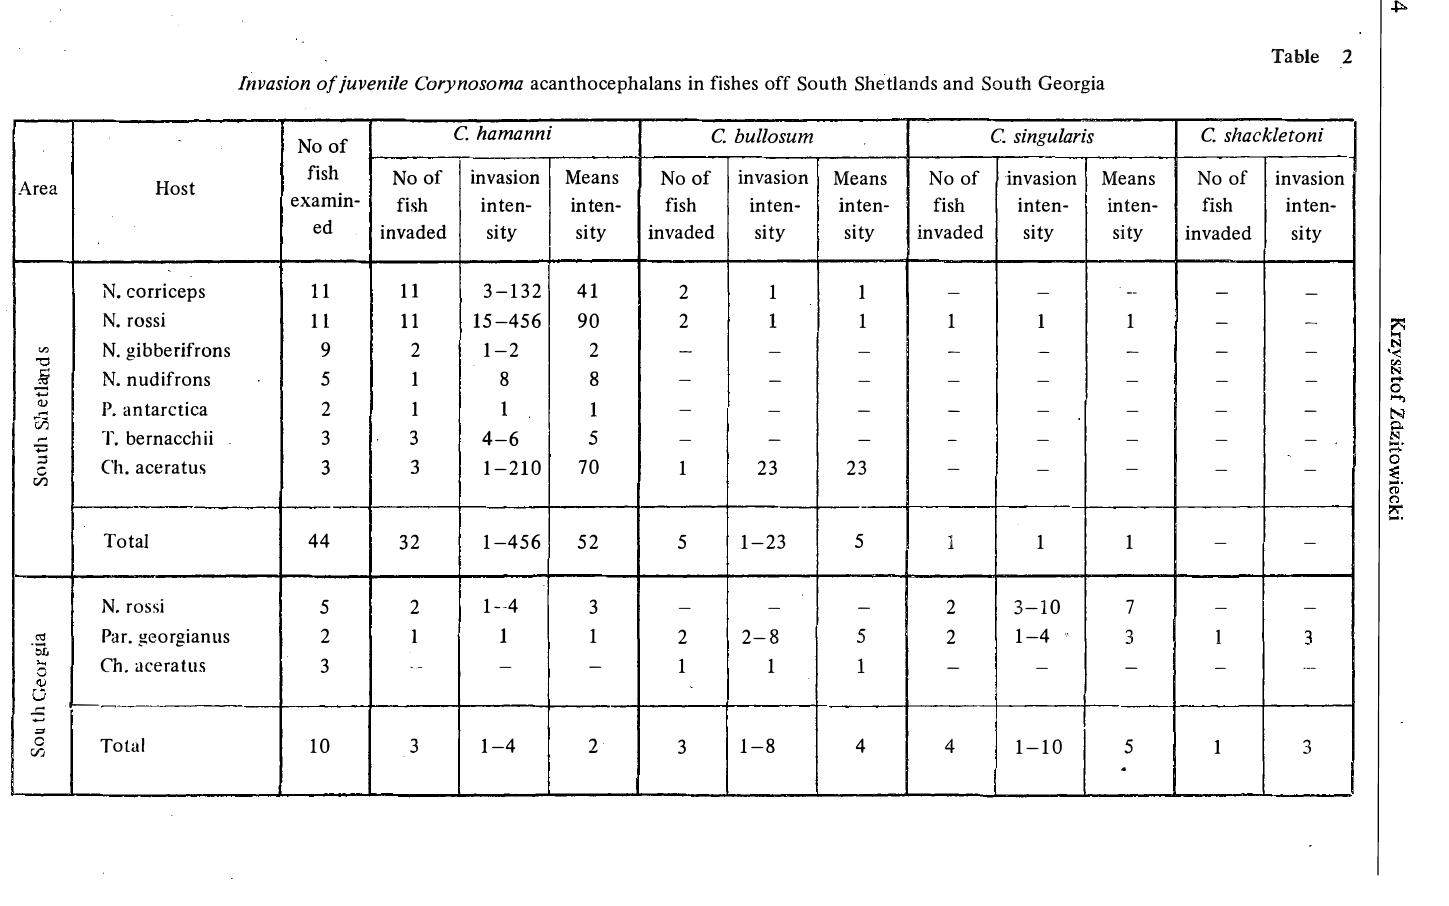
Invasion of juvenile Corynosoma acanthocephalans in fishes off South Shetlands and South